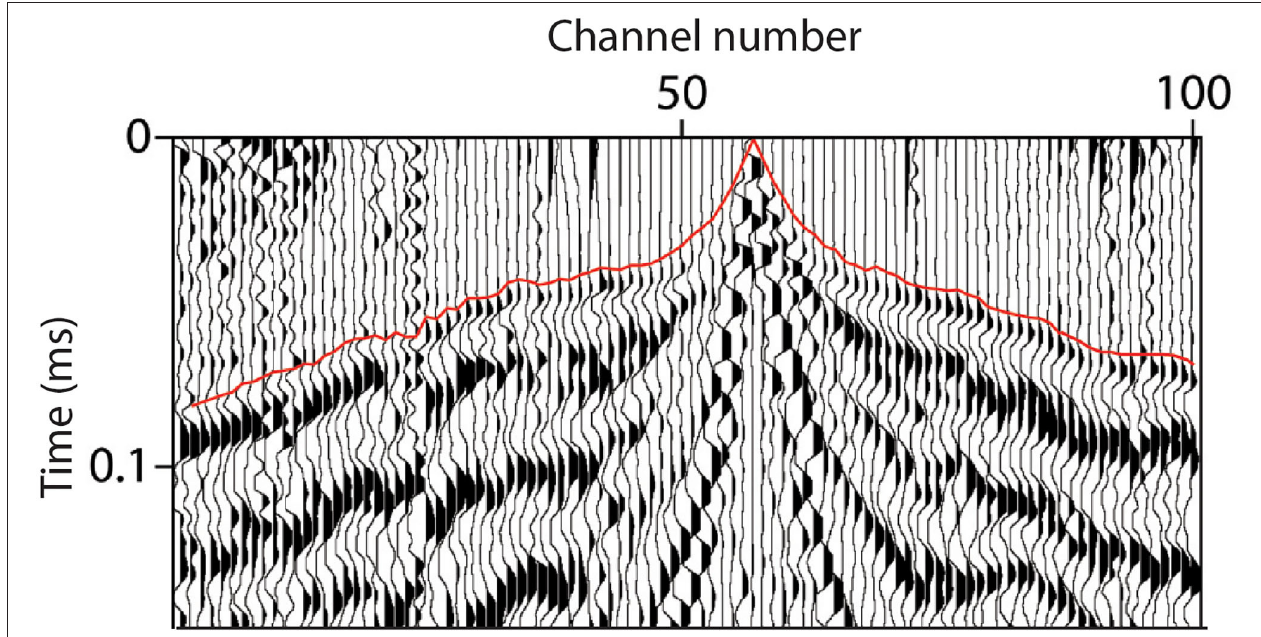
FIGURE 5 | An example shot break from Line 3 with the picked first arrivals shown as a red line. The shot was located midway up the south facing slope, at ∼ 100m mark in Figure 8C .